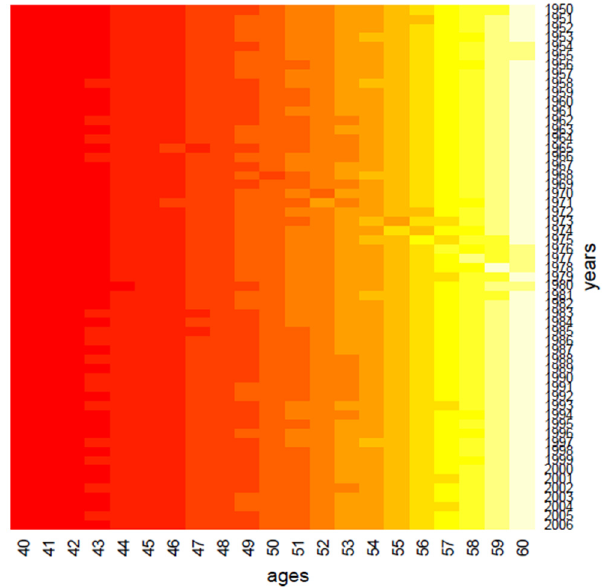
Figure 2. Clustering: the age effect.